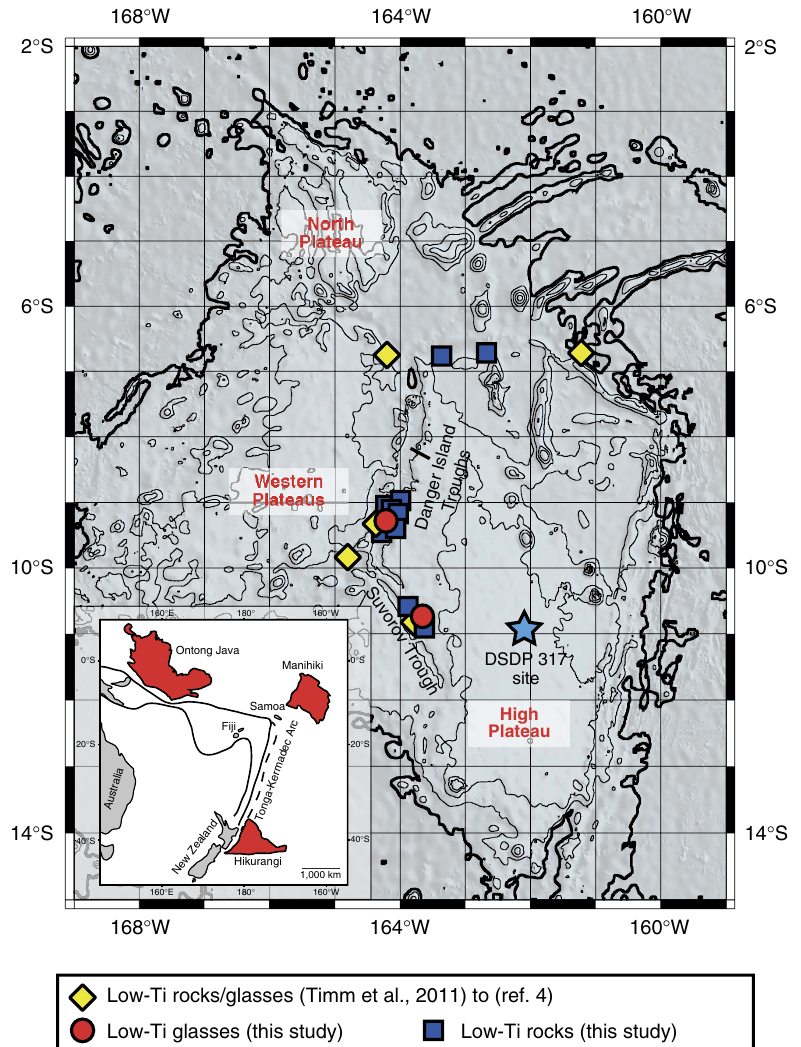
Figure 1 | Bathymetric map of the Manihiki Plateau. Red circles show dredge sites of glass samples used for this study from the SO193 and SO225 expeditions. Yellow diamonds show additional dredge sites where low-Ti rock samples have been recovered and reported in ref. 4, and blue boxes show dredge sites where low-Ti rocks were recovered during the SO225 expedition, illustrating the large-scale distribution of low-Ti lavas at Manihiki. The contour lines denote depth intervals of 1,000m with the thick black contour line showing a depth of 5,000m below sea level. The map was created based on GEBCO bathymetry data 65